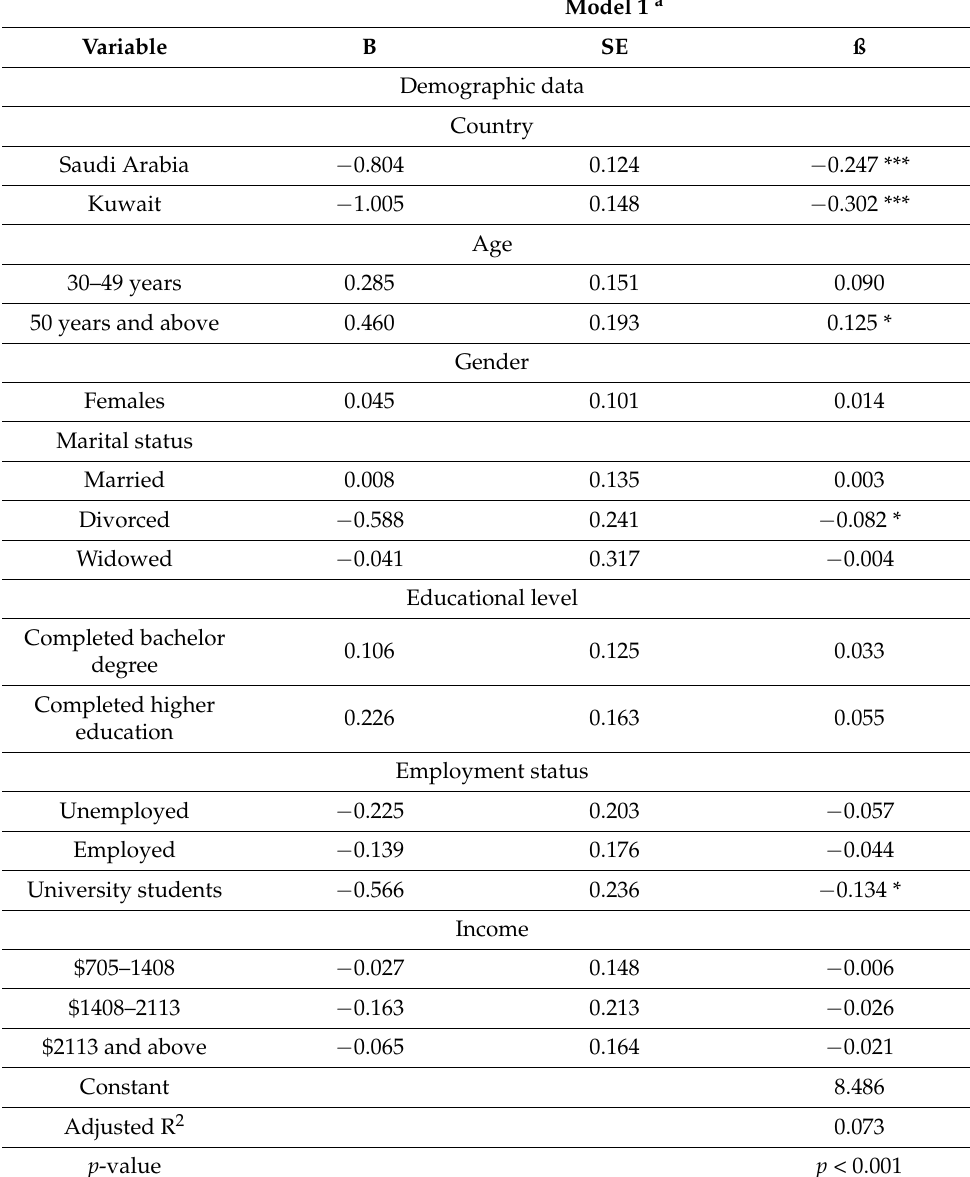
Table 5. Multiple regression analysis predicting participants’ COVID-19